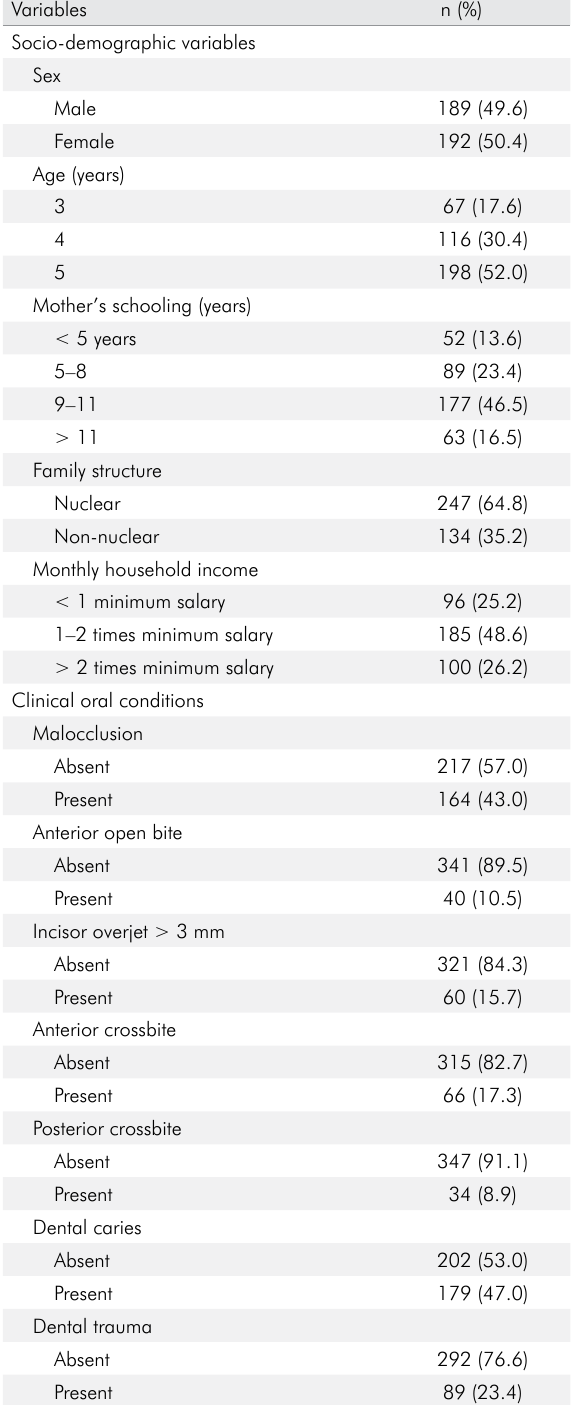
Table 1. Descriptive analysis of socio-demographic and clinical oral variables of preschool children (n =